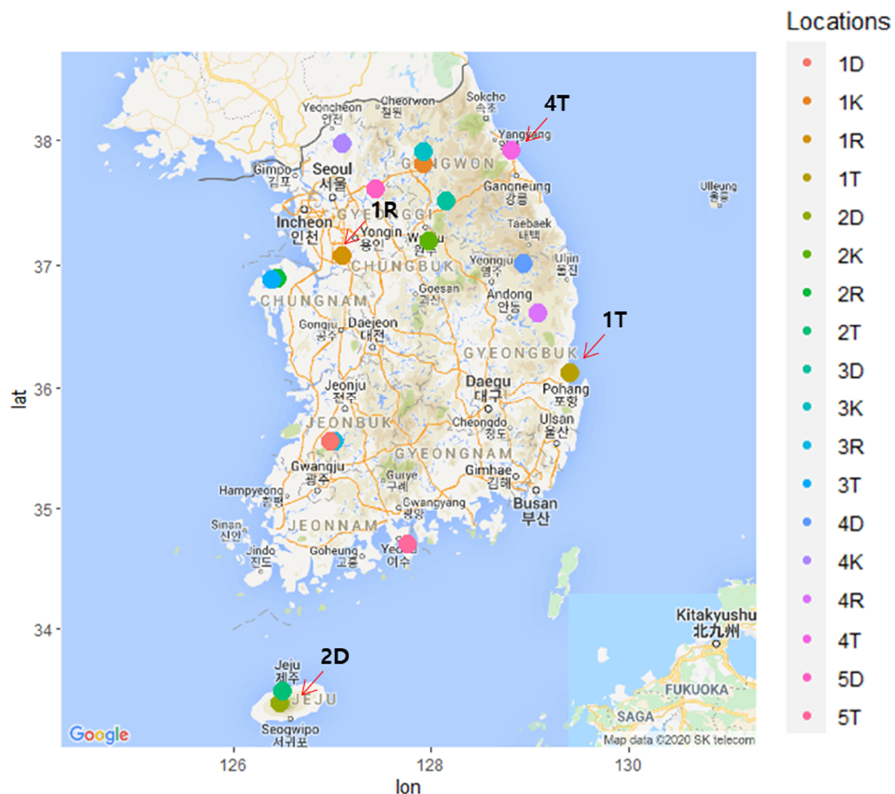
Figure 1. A map showing locations of 18 sampling sites in Korea. Each color circle represents sam- pling site labeled as 1D to 5T. Google map was modified to indicate sampling locations using ggmap package available in R programming (http://www.R-project.org, v3.6)